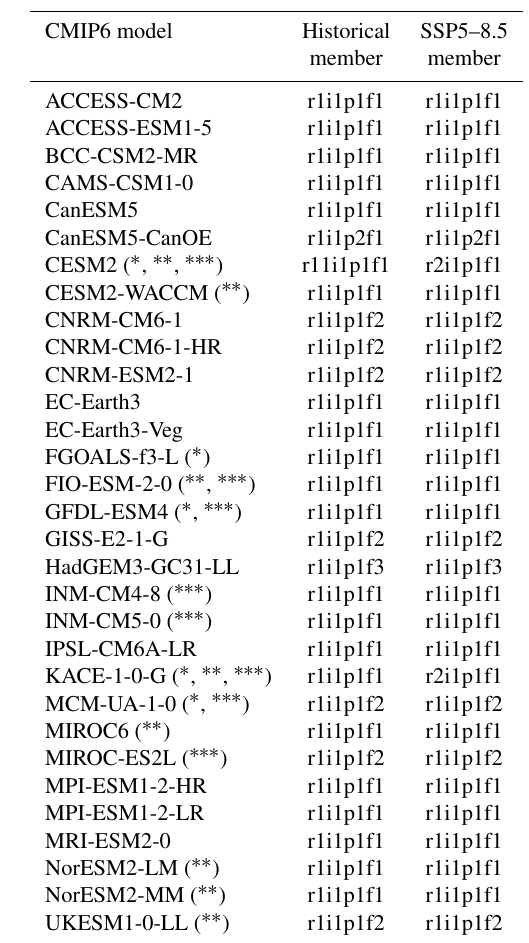
Table 1. CMIP6 models and members of historical and SSP5–8.5 simulations. An asterisk ( ∗ ) indicates models for which the sea sur- face height variable was not yet available at the time of this study. Models for which, on the one hand, the sea level pressure and the 10m horizontal wind variables, and, on the other, the mixed layer depth variable were not used for the mean state change analyses are indicated by two asterisks ( ∗∗ ) and three asterisks ( ∗∗∗ ), respec- tively. The other variables used are rainfall, sea surface temperature, 850hPa specific humidity, and 850 and 200hPa horizontal wind components.